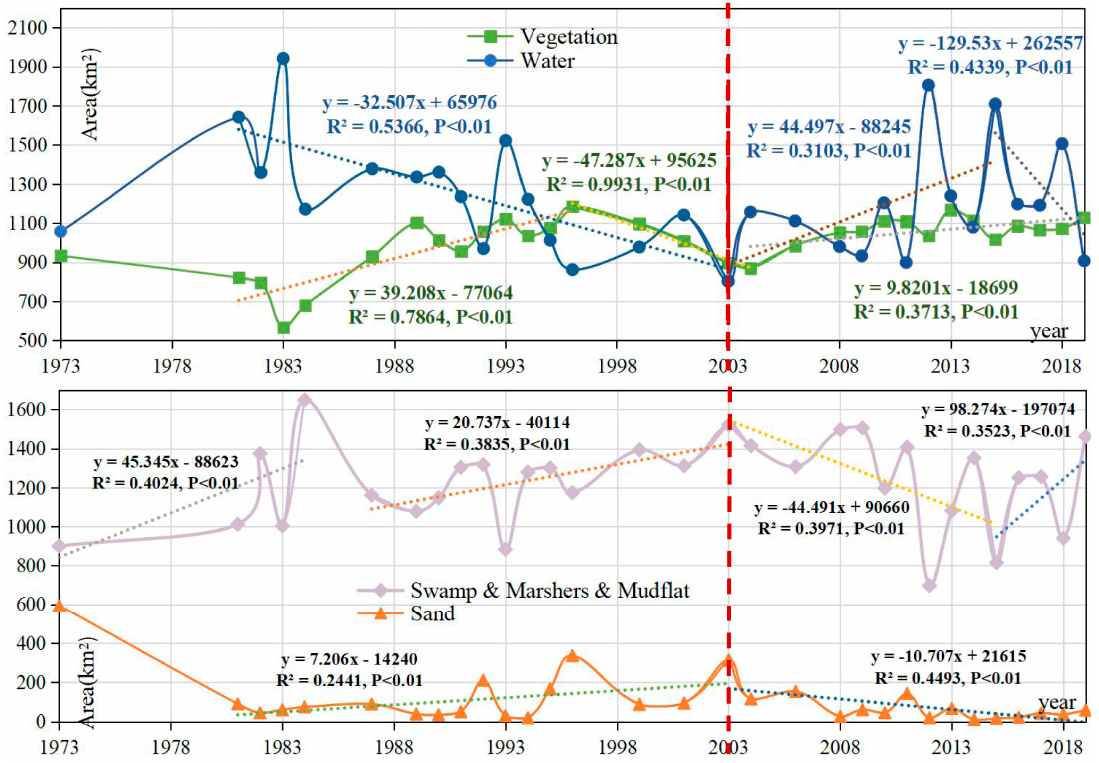
Figure 4. Long-term area variation of different landcover types in Poyang Lake from 1973 to 2019. The dotted vertical lines in red represent the year when the TGD began to store water.